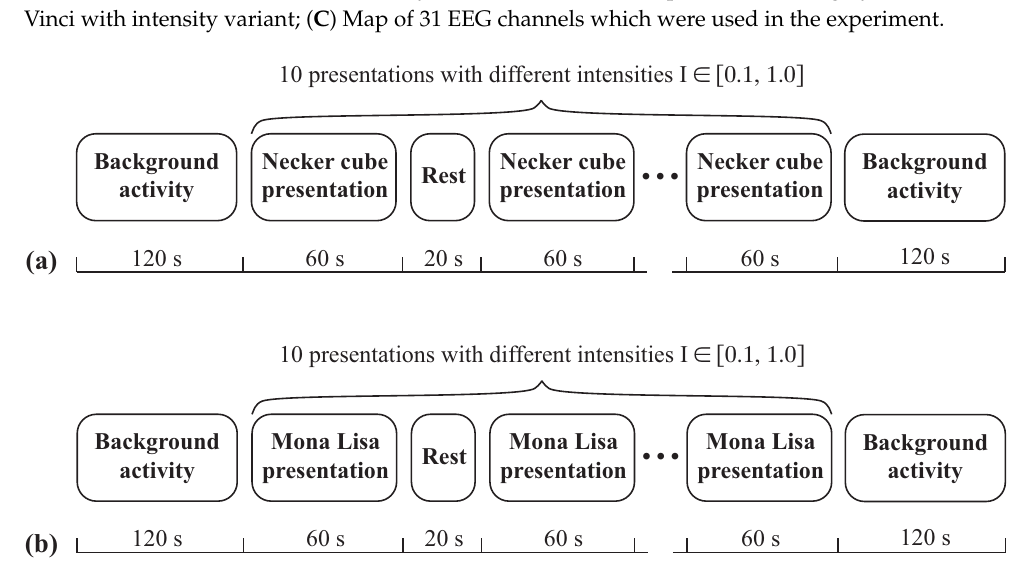
Figure 2. Schematic illustration of the experimental protocols. ( a ) Experiment with Necker cube as visual stimulus. ( b ) Experiment with Mona Lisa portrait as visual